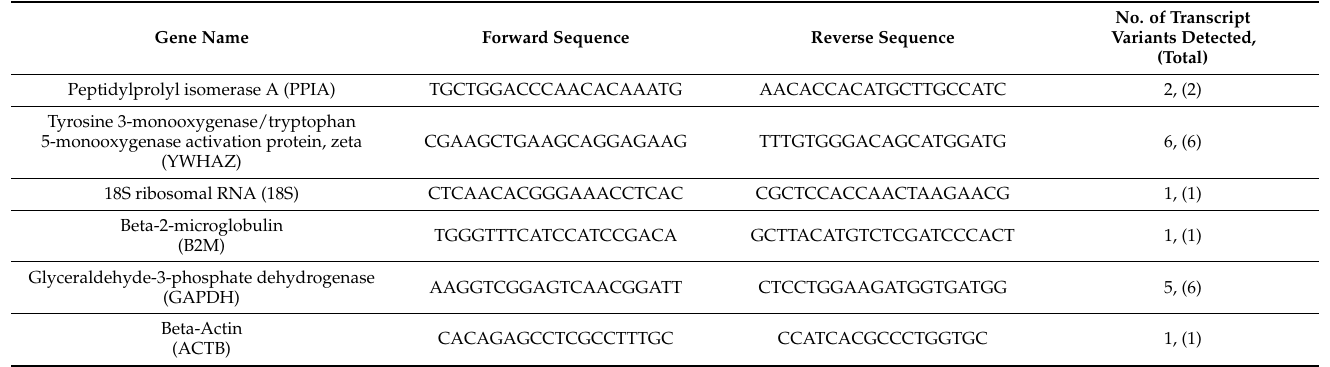
Table 1. Forward and reverse sequences for the 6 primers used to identify the potential reference